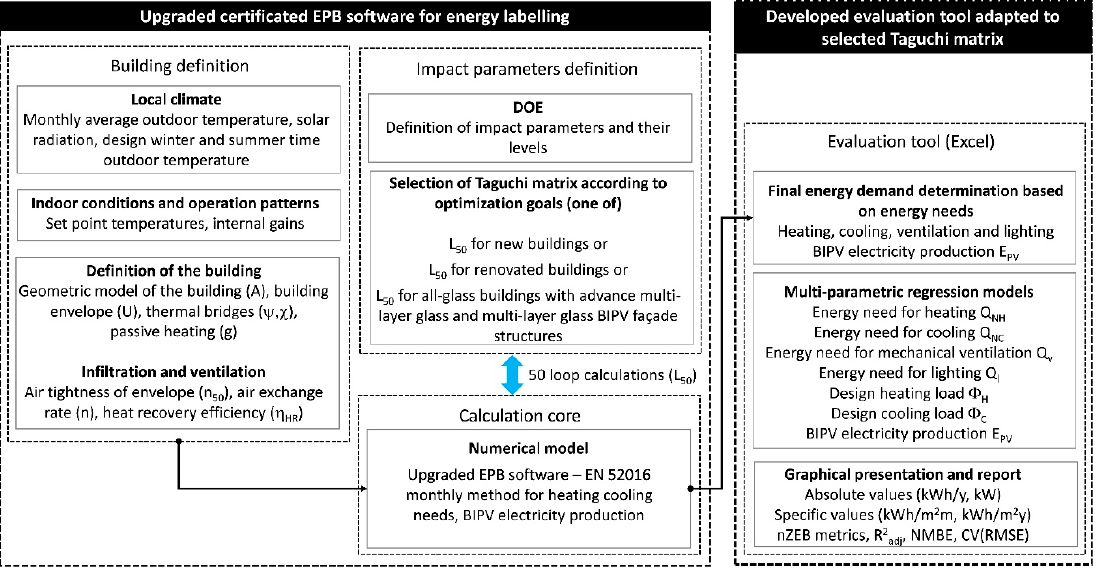
Figure 1. The structure of the software for fast modelling of buildings’ energy efficiency and nearly Zero Energy Buildings (nZEB) indicators based on multi-parametric regression models.